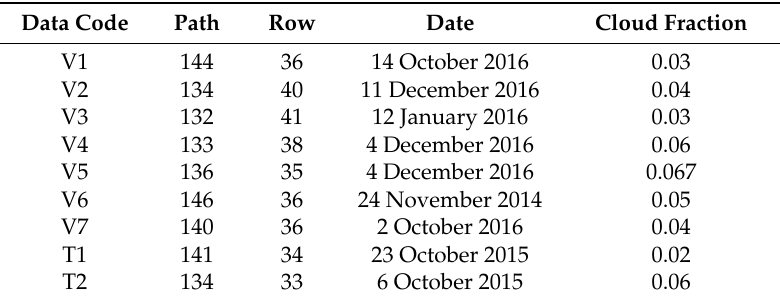
Table 1. Information of the Landsat 8 OLI data in this